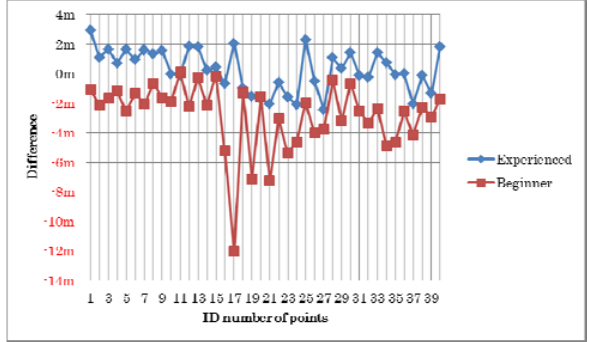
Figure 4. Comparison of accuracy evaluation of height measurement